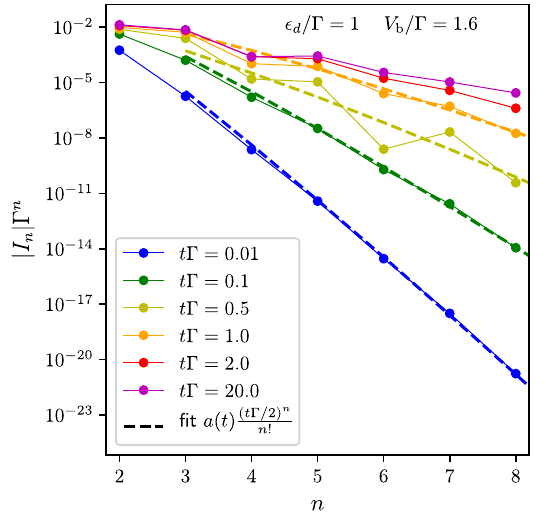
FIG. 9. Coefficients (absolute value) of the series for the current (circles with thin lines) in the asymmetric model ( ϵ 1 . 6 Γ ) computed at different times t (different colors). V b ¼ The apparent convergence radius decreases with time. For small values of t , we can observe that the series coefficients decrease faster than exponentially, which indicates an infinite convergence radius. The thick dashed line shows the corresponding fit with ð t Γ = 2 Þ n =n ! . For large enough t , the series converges toward the steady-state